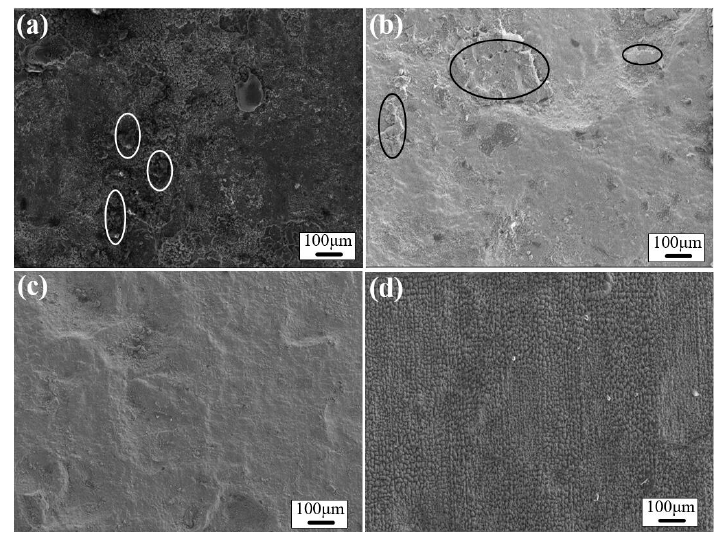
Figure 8. SEM images of paint and laser treated surface at different intensity ( a ) paint layer, ( b ) 6.2 W/cm 2 , ( c ) 11.9 W/cm 2 , and ( d ) 19.1 W/cm 2 .